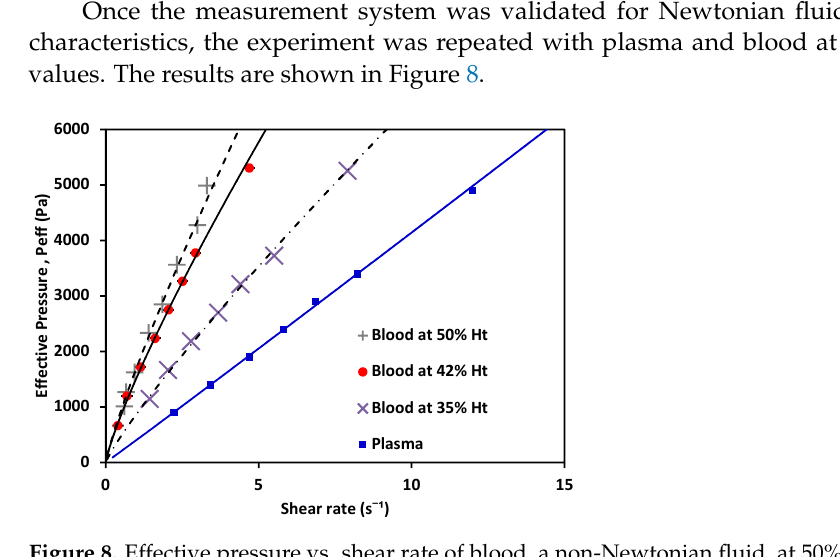
Table 4. Values for prefactor m and n for Newtonian and non-Newtonian fluids. Sample